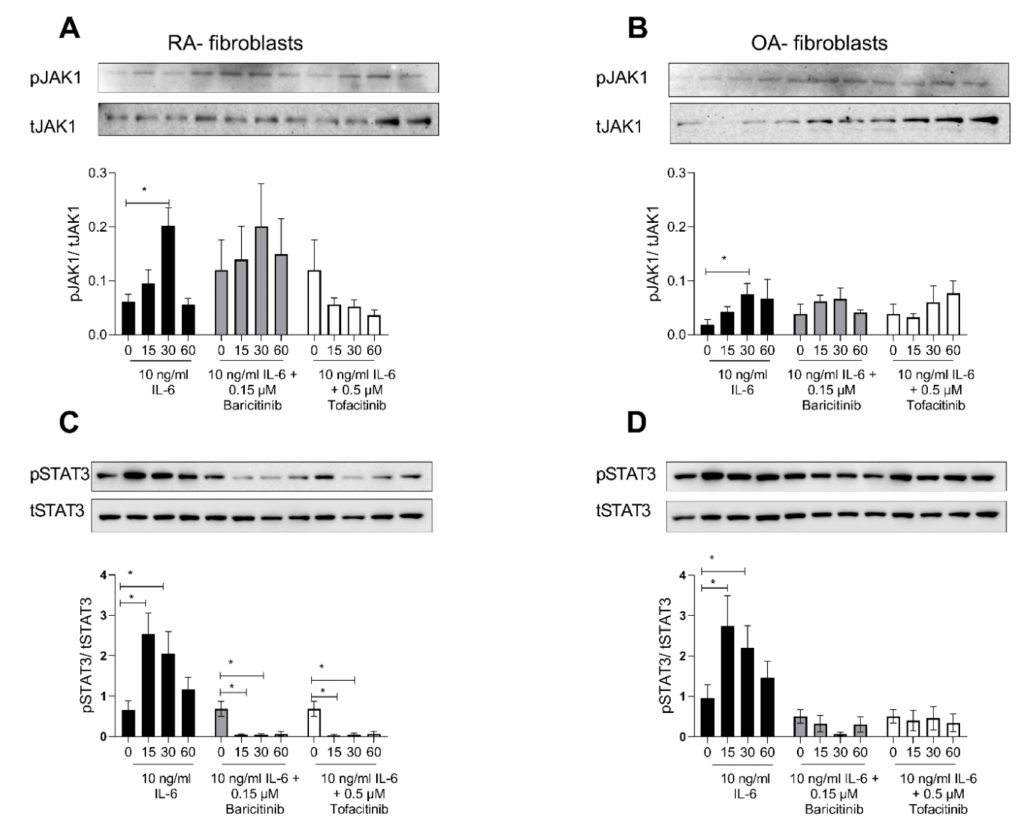
Figure 4. Tofacitinib and Baricitinib showed comparable inhibition of IL-6 induced STAT3- phosphorylation. ( A ) Western blot for pJAK1 compared to total Jak1 in RASF stimulated for 0, 15, 30 or 60 min with 10 ng / mL Il-6. Cells were also treated with 0.15 µ M Baricitinib or 0.5 µ M Tofacitinib. Quantification of at least 5 independent experiments are given in the graph underneath the blot. ( B ) Western blot for pJAK1 compared to total Jak1 in OASF stimulated with 10 ng / mL Il-6 and treated with 0.15 µ M Baricitinib or 0.5 µ M Tofacitinib. Quantification is given in the graph underneath the blot. ( C ) Western blot for pSTAT3 compared to total STAT3 in RASF stimulated for 0,15, 30 or 60 min with 10 ng / mL Il-6. Cells were also treated with 0.15 µ M Baricitinib or 0.5 µ M Tofacitinib. Quantification of at least five independent experiments is given in the graph underneath the blot. ( D ) Western blot for pSTAT3 compared to total STAT3 in OASF stimulated with 10 ng / mL Il-6 and treated with 0.15 µ M Baricitinib or 0.5 µ M Tofacitinib. Quantification is given in the graph underneath the blot. A two-way RM-ANOVA was performed for statistical testing. Data are presented as mean values with SEM. A p -value p ≤ 0.05 was considered to show statistical significance and is indicated by